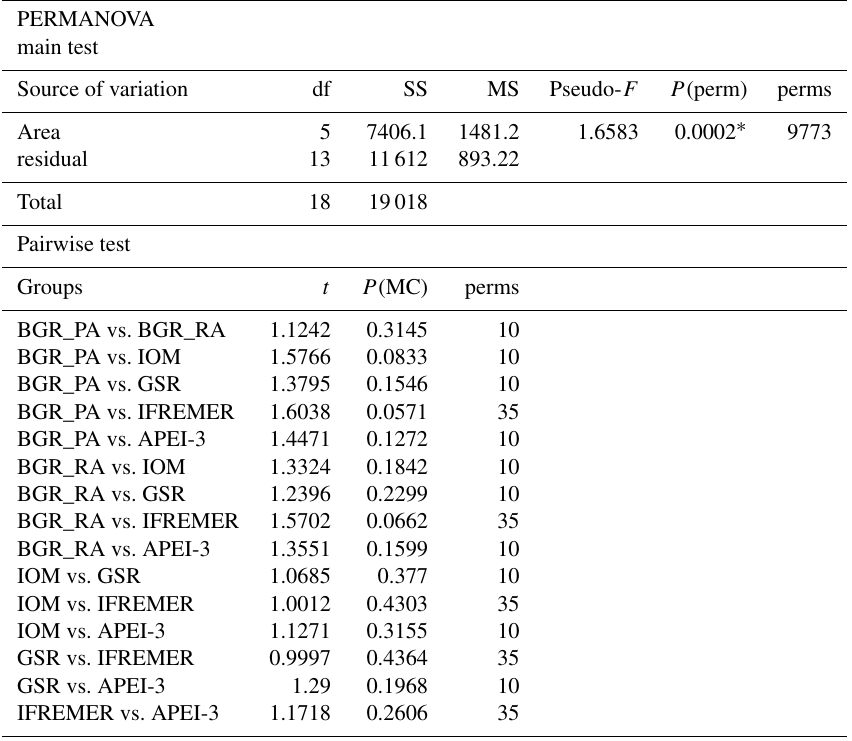
Table 4. PERMANOVA main and pairwise test results for nematode genus composition. PERMANOVA design with one fixed factor (area; six levels). P values calculated by permutation (9999 permutations) at 5% significance level. df is degrees of freedom, SS is sum of squares, MS is mean squares, Pseudo- F and t are effect size, P (perm) and P (MC) are permutational or Monte Carlo P value, and perms is number of unique permutations. Asterisks indicate significant P values.